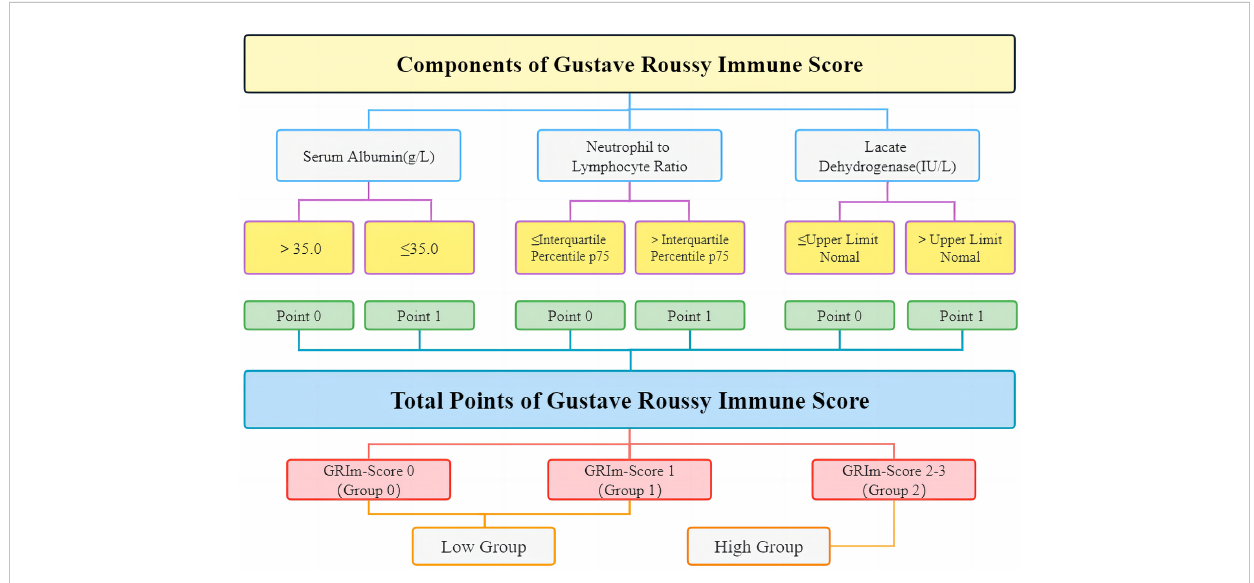
FIGURE 2 The detailed de fi nition and grouping items of GRIm-Score. GRIm-Score, Gustave Roussy Immune